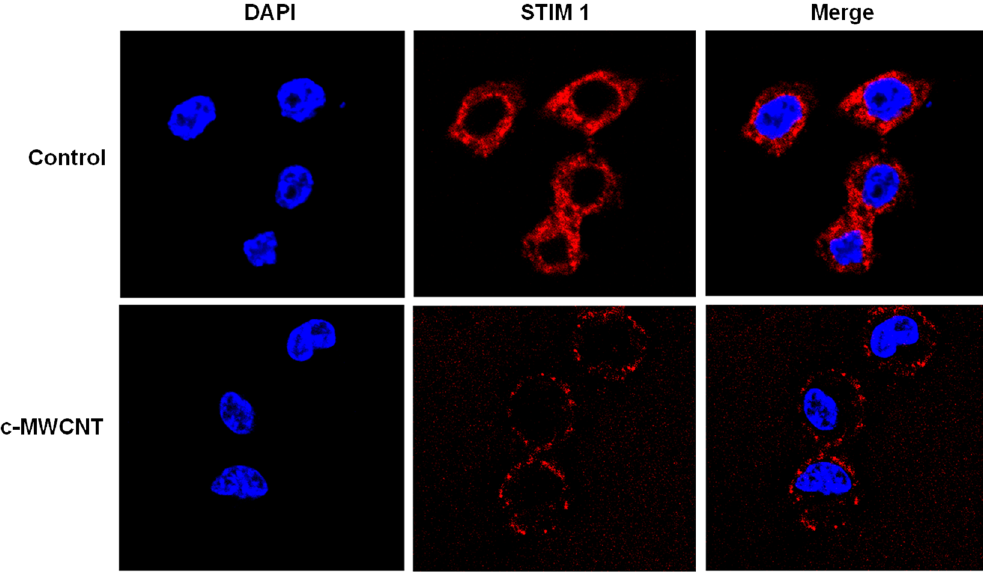
Figure 5. Confocal microscopy showing the translocation of STIM1 from the cytoplasm to the plasma membrane (PM) in RAW264.7 macrophages in response to c-MWCNTs (50 μ g/ml, 24 h) and TG (1 μ mol/L, 30 min) exposure. Both c-MWCNTs and TG strongly stimulated the translocation of STIM1 to the PM and appeared in a discrete punctate manner in the PM area.